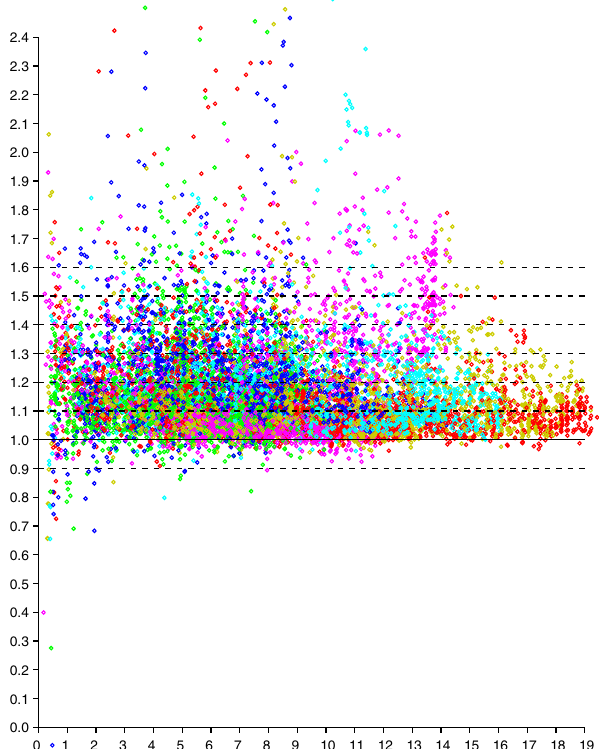
Figure 3. Scattergram of ratio of reported to actual distance (vertical axis) versus actual distance (horizontal axis—meters). Results from six responders color coded. (Dashed lines are shown for ratios of 0.9, 1.0 1.1, 1.2 . . .